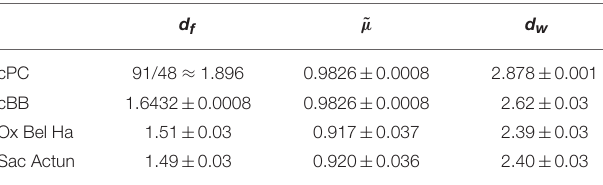
TABLE 1 | Fractal dimension d f , conductivity exponent ˜ µ and walk exponent d w of critical percolation cluster (cPC), critical backbone percolation cluster (cBB) and Tulum karst